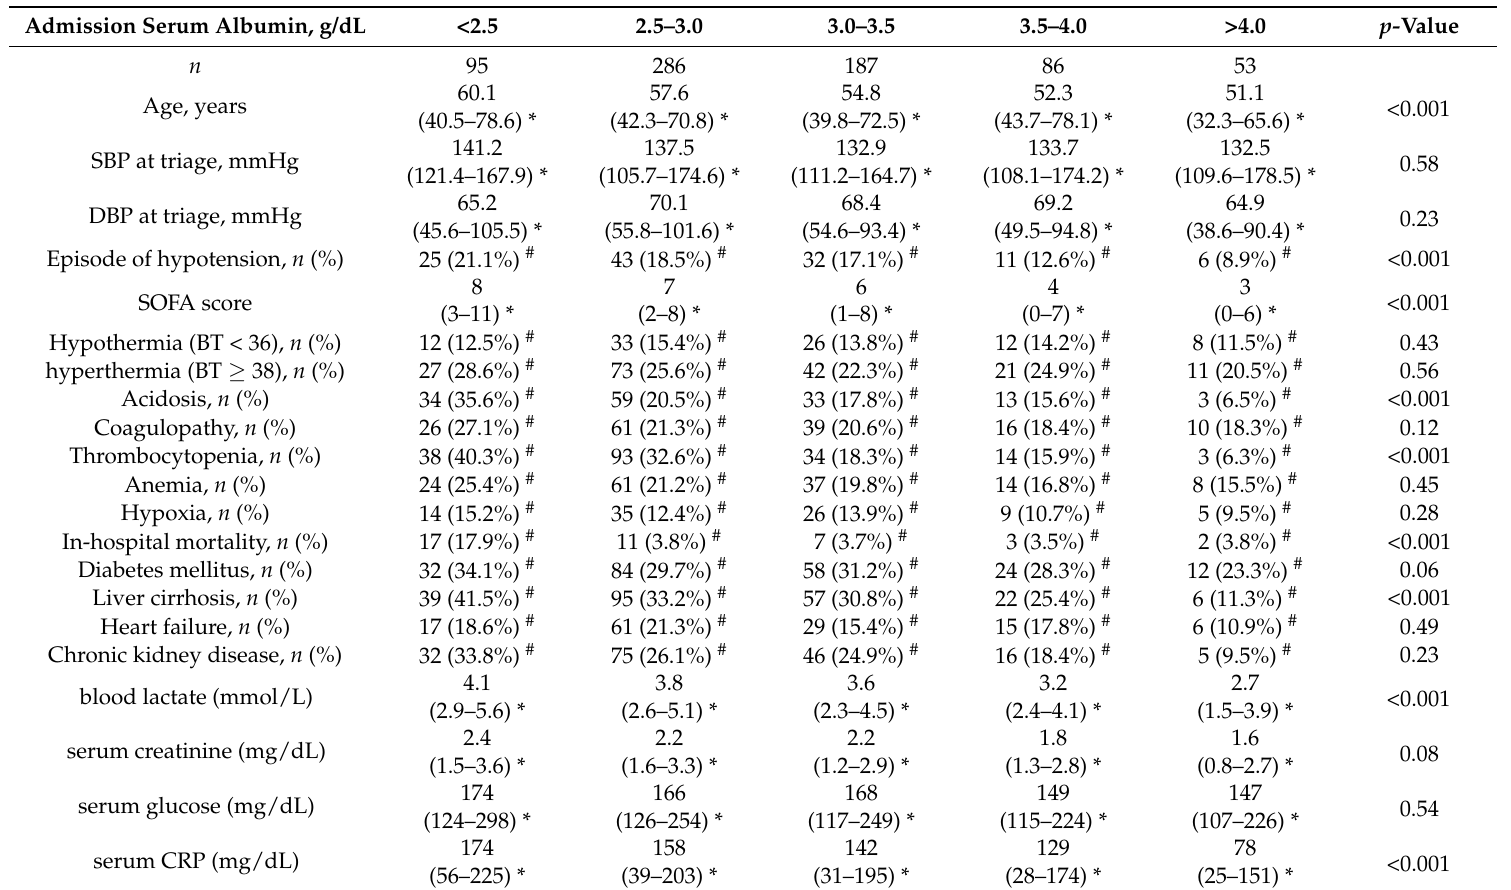
Table 2. Comparison of demographic and clinical characteristics and laboratory findings on ED arrival among NF patients with different levels of serum albumin. Admission Serum Albumin,